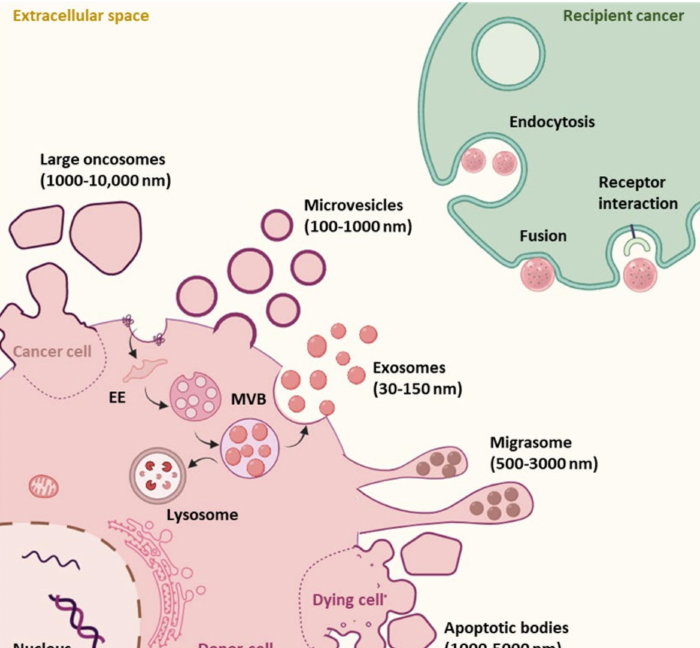
Figure 1. Schematic representation of extracellular vesicle subtypes, biogenesis and uptake. Ex- tracellular vesicles (EVs) are classified into different subtypes based on their size and mode of secretion. Exosomes (30–150 nm) are formed within the endosomal system. Maturing from the early endosome to the late endosome, ESCRTs and other related proteins then assist in wrapping recruited cytosolic cargoes with endosomal lipid membrane to form independently closed intralumi- nal vesicles inside multivesicular bodies (MVBs). MVBs are then either directed toward lysosome for degradation or toward plasma membrane where they fuse to be released from the intraluminal vesicles into extracellular space as exosomes by exocytosis. Microvesicles or ectosomes (100–1000 nm) shed directly from the plasma membrane, encapsulating cytosolic contents. Apoptotic bodies (1000–5000 nm) and large oncosomes (1000–10,000 nm) are secreted from the membrane blebbing of apoptotic cells and cancer cells, respectively. Migrasomes (500–3000 nm) are generated specifically by migrating cells. EVs are transported via bodily fluids to their target recipient cells. EVs may directly fuse with the recipient cell plasma membrane to deliver their contents and can interact to the surface receptors of the target cells or get taken up into the recipient cells through different endocytic mechanisms. Created with https://biorender.com/ (8 October